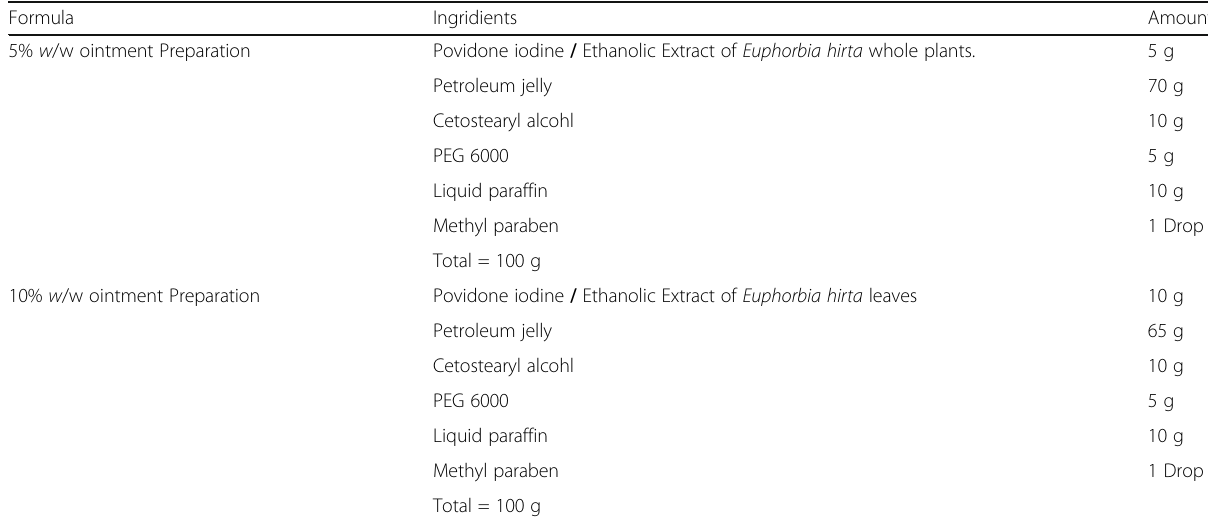
Table 1 Preparation of medicated formulations with ethanolic extract of E. hirta leaves Formula